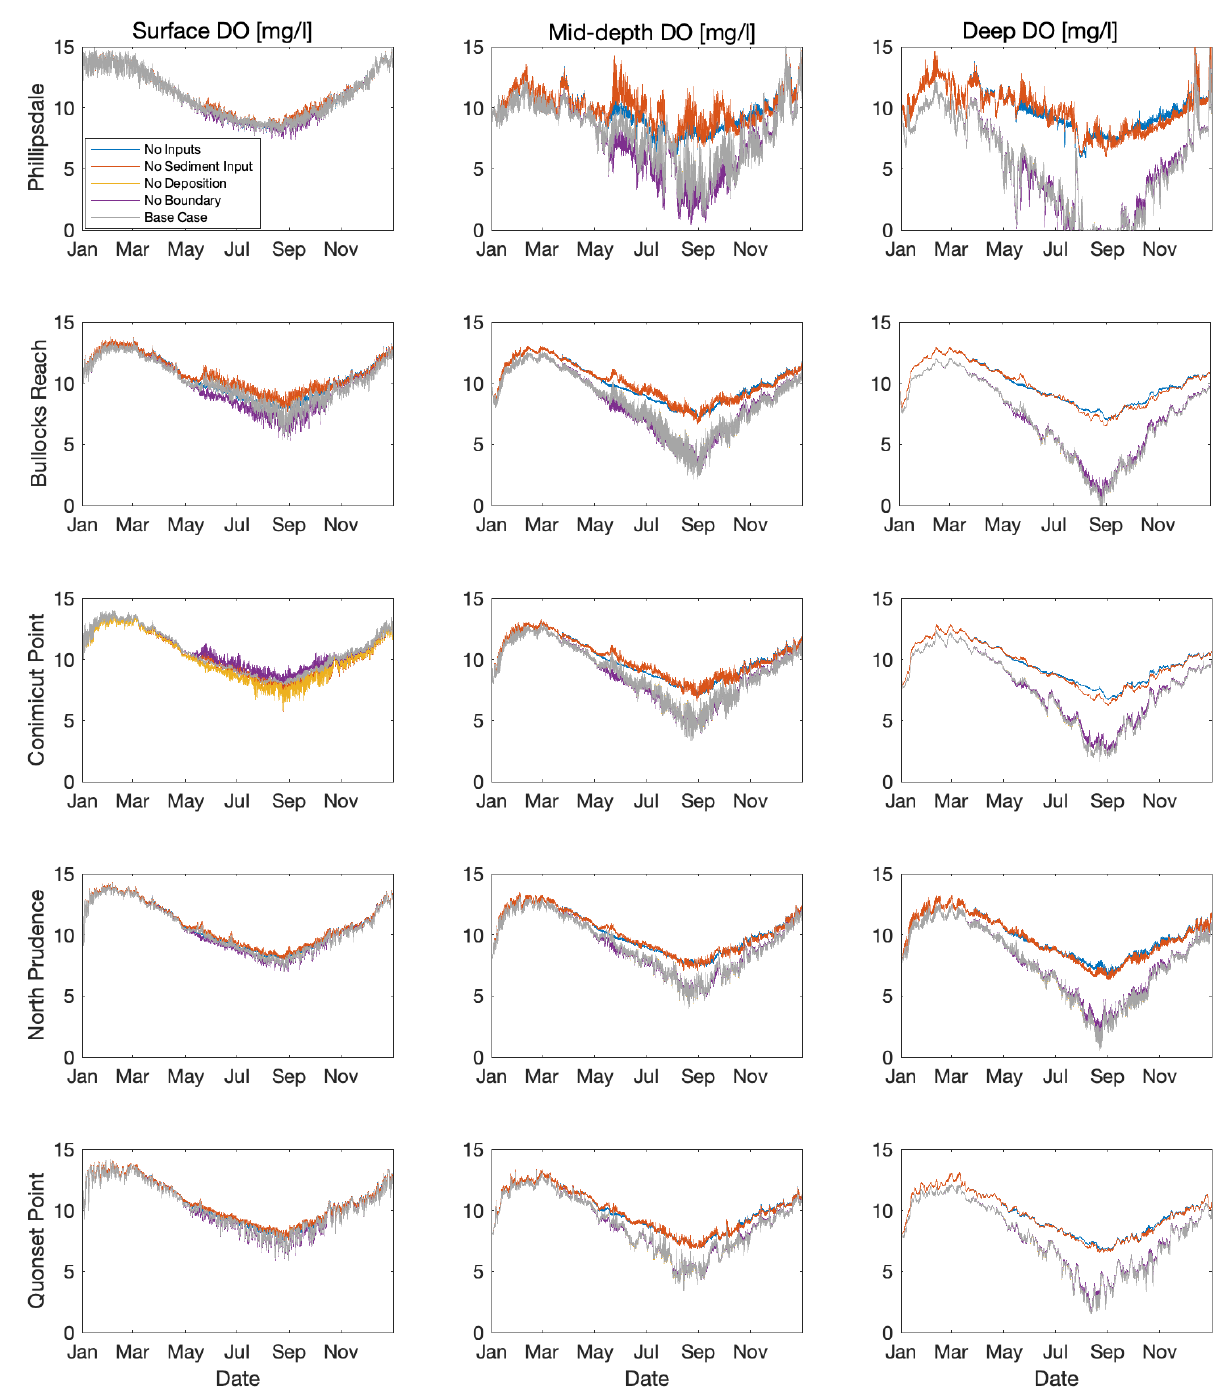
Figure 9. Dissolved oxygen WASP simulations over the year comparing different scenarios of nitrogen inputs. Columns are layer of interest and rows are the location of interest.